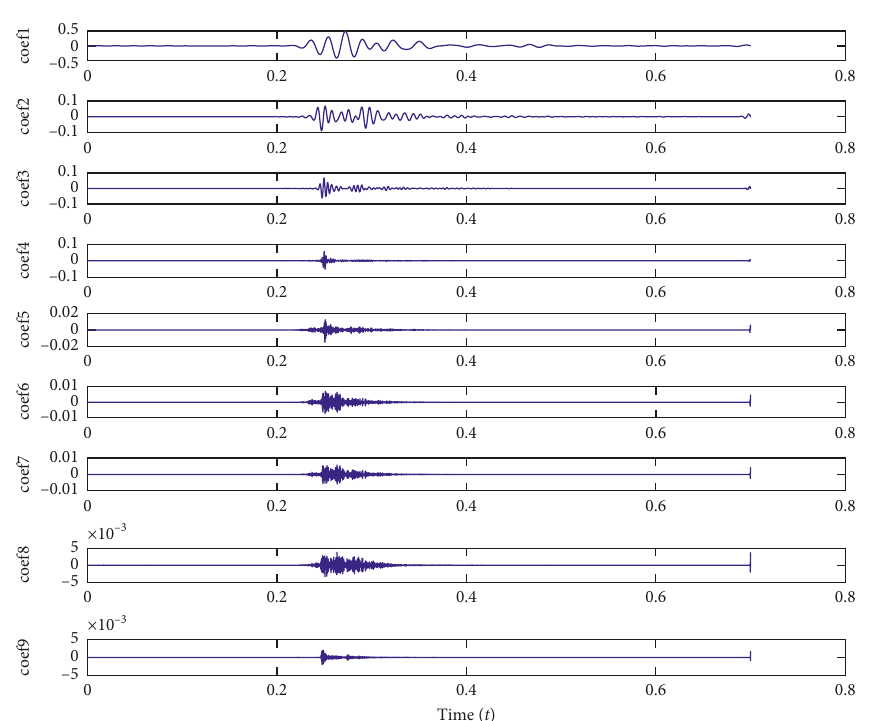
Figure 5: Time-varying graph of continuous wavelet